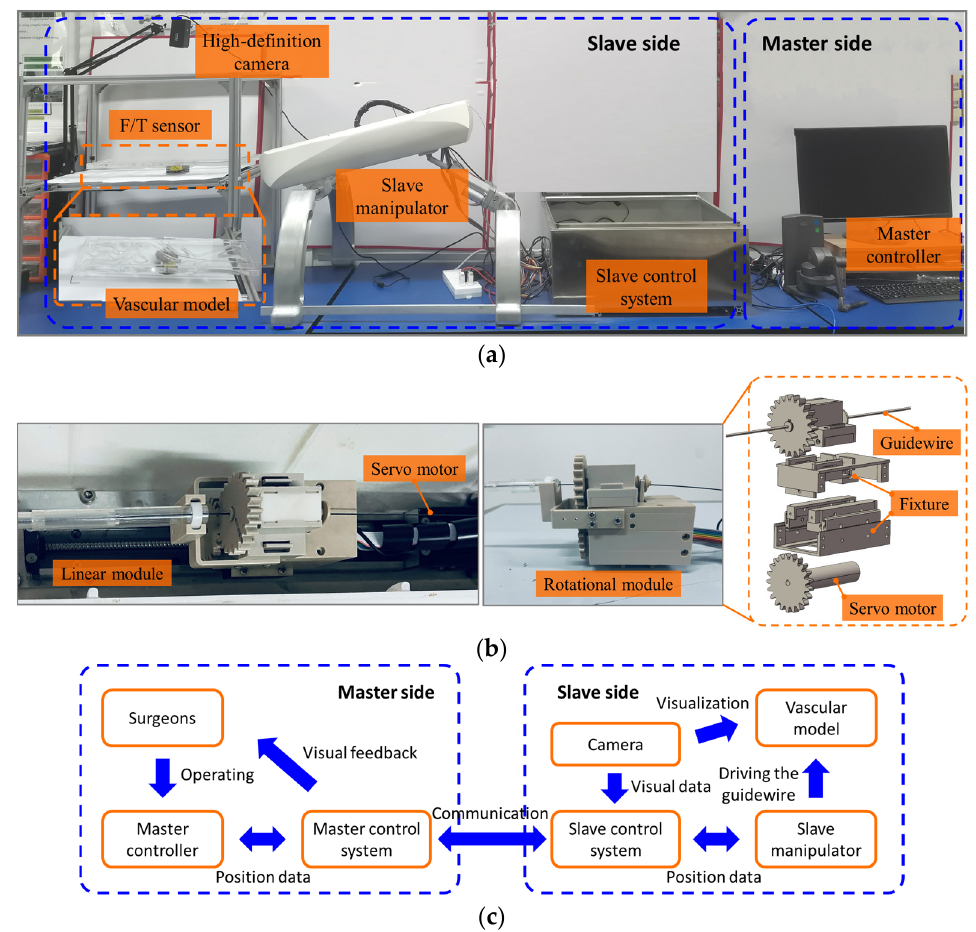
Figure 1. The framework for catheterization skill assessment: ( a ) the experimental setup for data collection; ( b ) the rotational and linear modules of the slave manipulator; ( c ) a schematic diagram of the master-slave vascular interventional surgical robot.